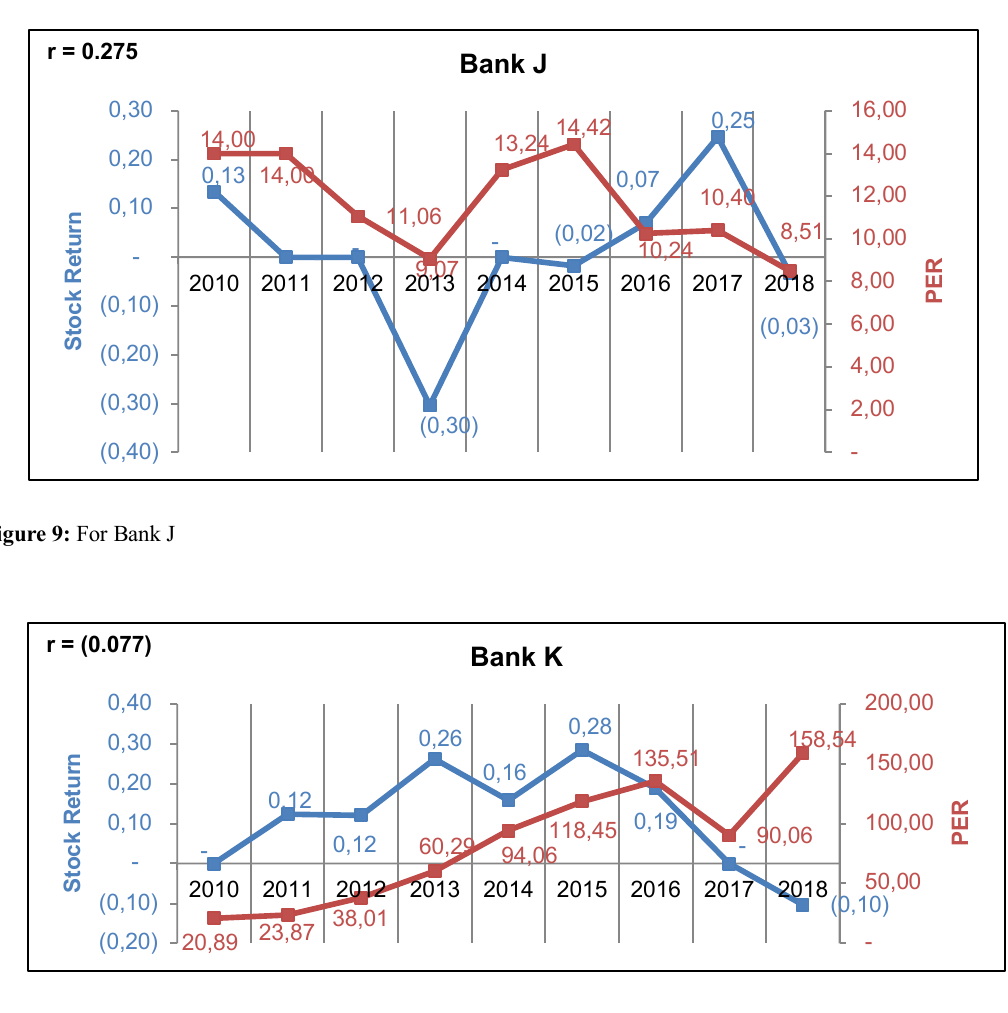
Figure 10: For Bank